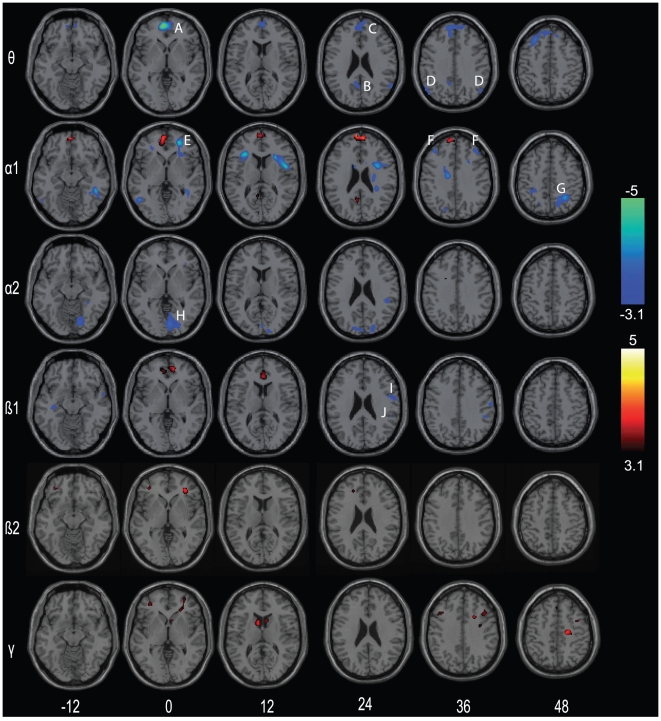
Illustrations of EEG-BOLD signal correlations during the retention interval.Positive (red) and negative (blue) correlations are shown for the following frequency bands: theta/θ: 5–7 Hz; alpha1/α1: 8–10 Hz; alpha2/α2: 10–13 Hz; beta1/β1: 13–20 Hz; beta2/β2: 20–30 Hz and gamma/γ: 30–40 Hz. All EEG-BOLD signal correlations are shown at an uncorrected voxel threshold of p<0.001 (t = 3.1) and a corrected cluster threshold of p<0.01. Numbers on the bottom indicate z-coordinates in MNI space. Capital letters in the different panels indicate the following brain regions: anterior cingulate cortex/ACC (A), posterior cingulate cortex/PCC (B), medial frontal gyrus/MPFC (C), posterior parietal cortex/PPC (D), inferior frontal gyrus (E), dorsolateral prefrontal cortex/DLPFC (F), precuneus (G), lingual gyrus (H), precentral gyrus (I), and border superior temporal gyrus and inferior parietal lobule (J). Correlations are shown for grey and white matter regions.